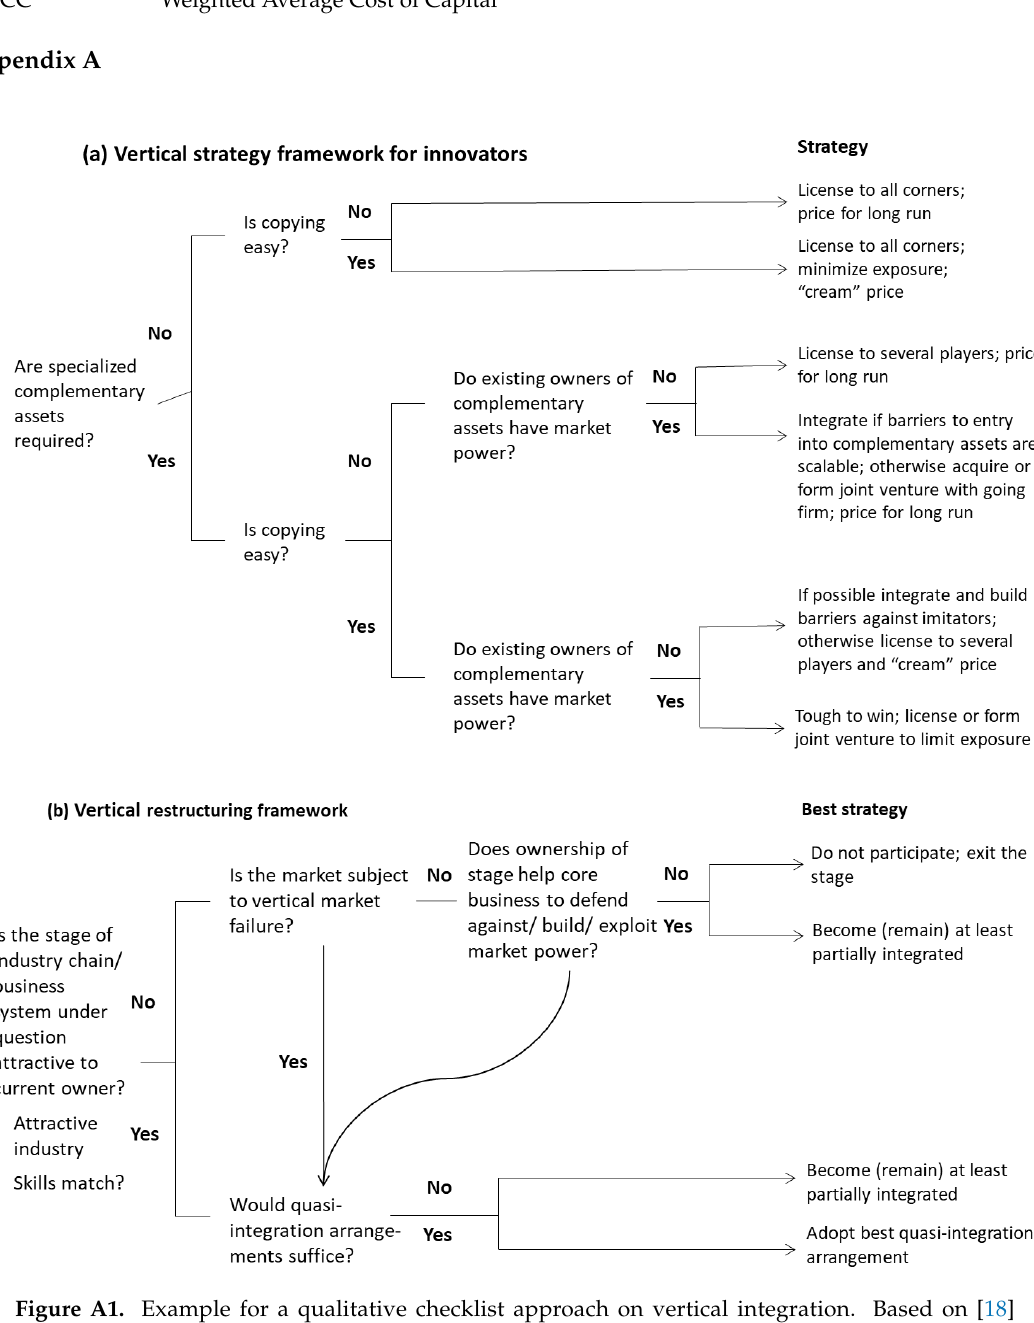
Figure A1. Example for a qualitative checklist approach on vertical integration. Based on [18] (pp. 15, 19), modified.